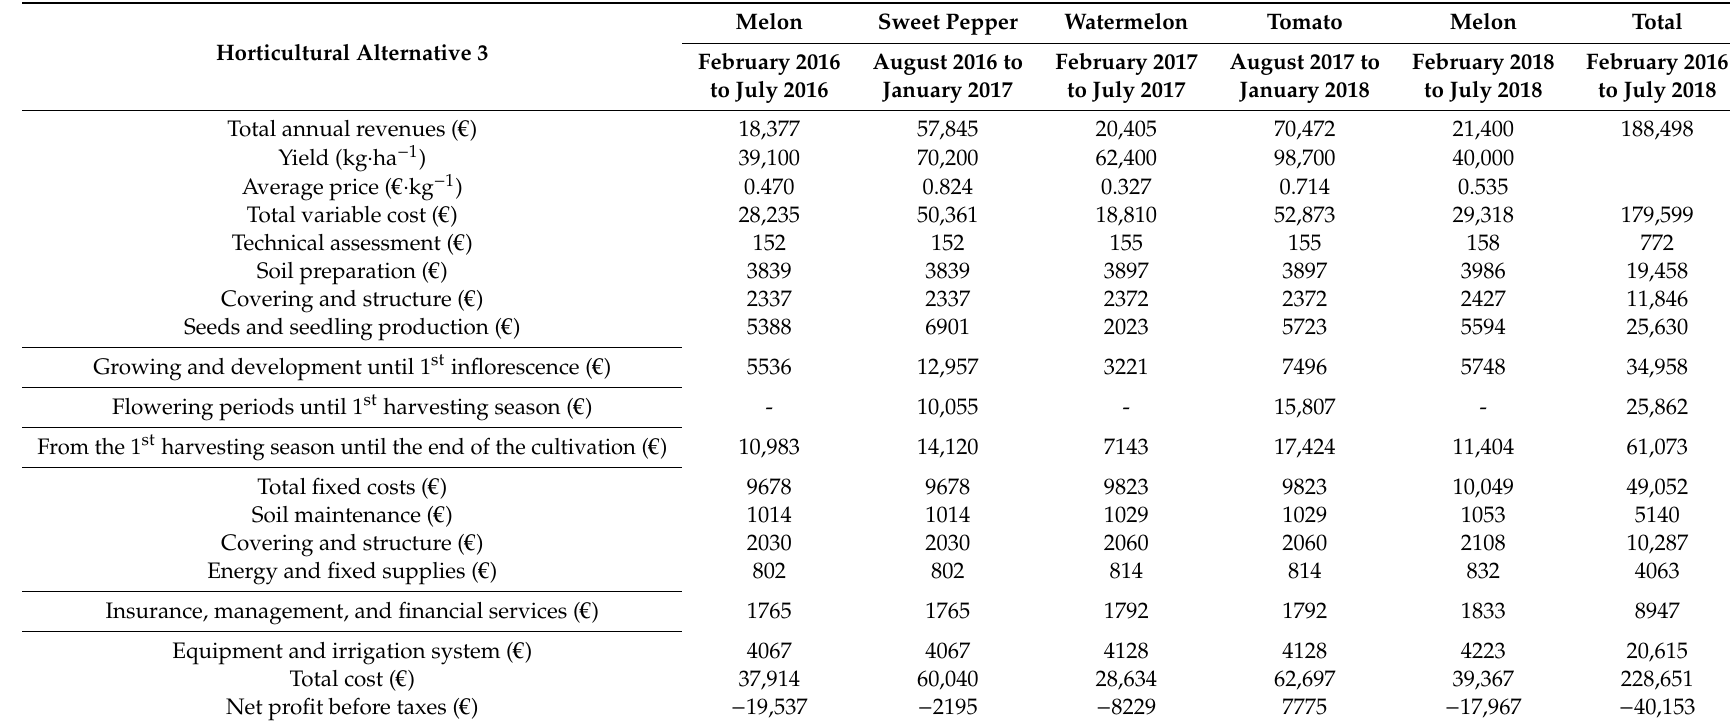
Table A5. Revenues and expenses per hectare imputed to the cultivation of the horticultural alternative 3 in a 30-month cycle (2016–2018).